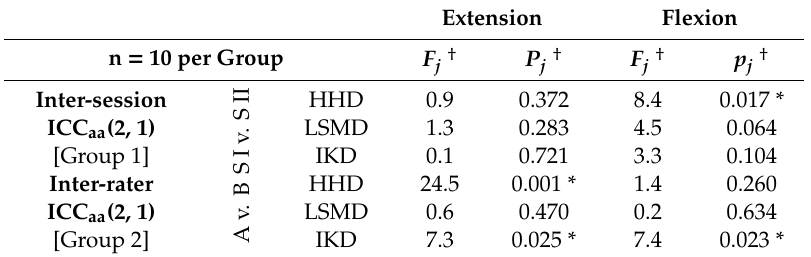
Table 5. Significance of the between-sessions and between-raters component of variance for ICC tests. Extension Flexion n = 10 per Group Inter-session